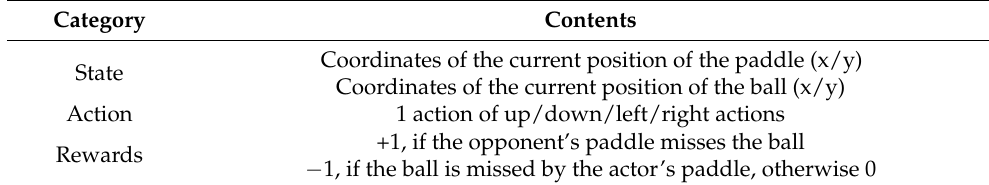
Table 6. Objects of learning in the maze